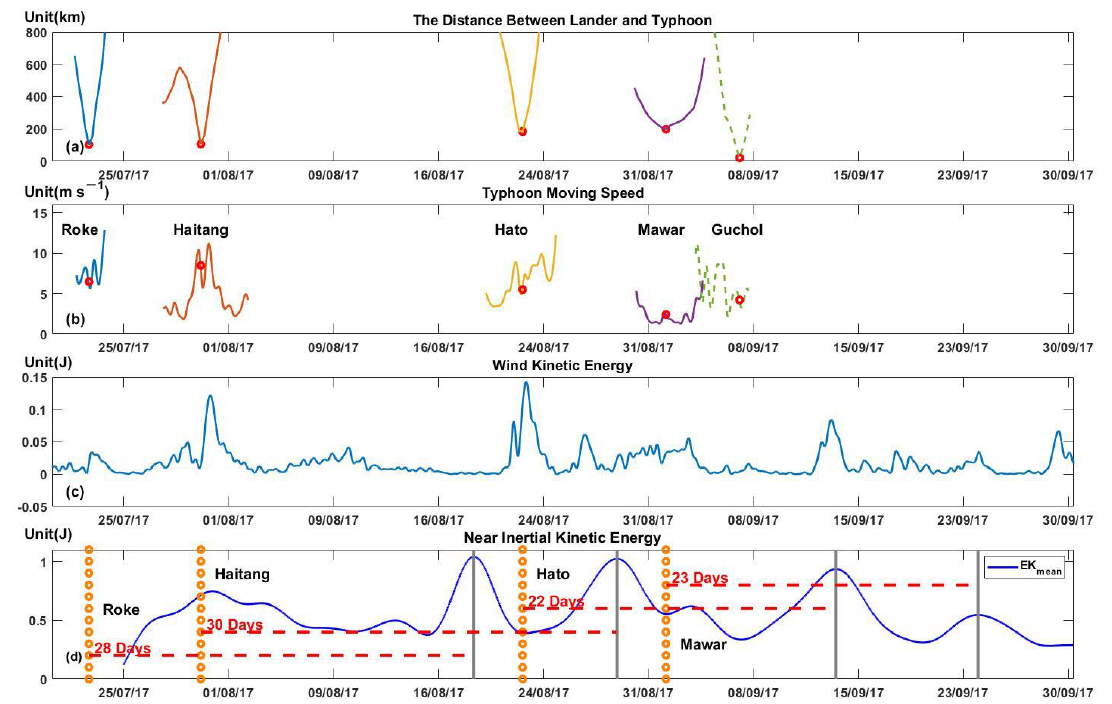
Figure 6. All typhoons characteristic energy with the closest distance of less than 20 km after July 2017. The data are selected from the Japan Meteorological Agency. There were five typhoons that met this condition: Roke, Haitang, Hato, Mawar, and Guchol. Figure ( a ) shows the time series of distance between the Lander and five typhoons. ( b ) The moving speeds of the centers of the five typhoons. The red dots in ( a ) mark the time corresponding to the nearest locations of the typhoon and Lander. At the same time, the corresponding times in ( b ) are marked in this figure. Figure ( c ) shows the characteristics of wind kinetic energy during this period. The data are derived from CCMP wind field data. ( d ) The depth average of NIKE, and the time interval is selected from 25 July to 1 October. The closest times to Lander of four typhoons, Roke, Haitang, Hato, and Mawar, which produced NIWs, are also marked with orange circles. The gray line marks the time when NIKE is strongest. The red dashed lines represent the time between the typhoons and the maximum value of NIKE. The specific times are also marked in ( d